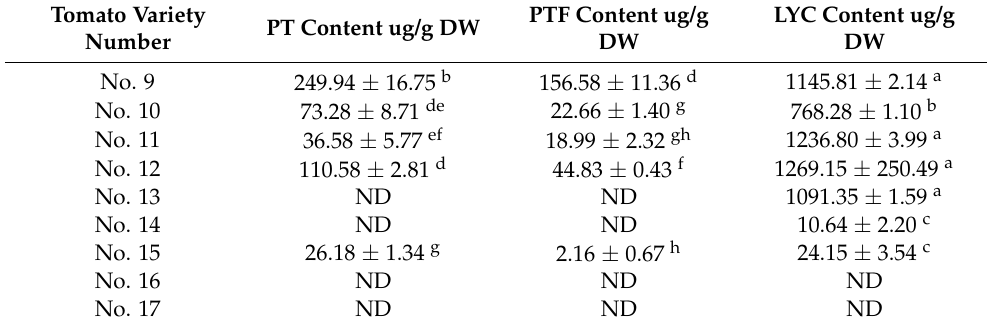
content is not detected.